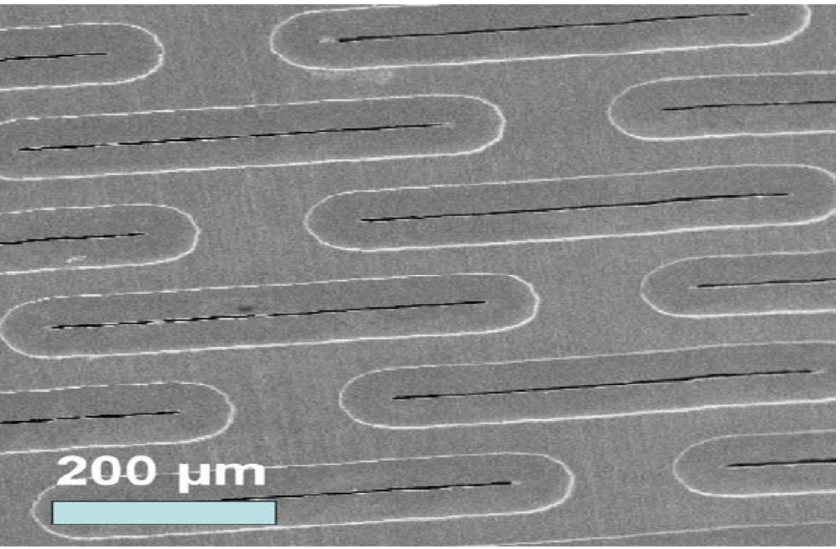
Figure 3. Scanning Electron Microscopy (SEM) Diagram of Slotted Porous Structure Membrane. The membrane was connected with an oscillating arm, then the oscillating arm was initiated with an electrochemical oscillator in order to create shear rate over the membrane surface. A flow diagram of the oscillating microfiltration membrane with oscillating system for separating oil and water is shown in Figure 4. The oscillating frequency and amplitude scale for membranes was varied between 0 and 10 Hz, and 0 and 10 mm, respectively. As a result, the shear rate was produced in the vicinity of the membrane outer surface. The constant flux through the membrane was created using a positive displacement (PD) pump.